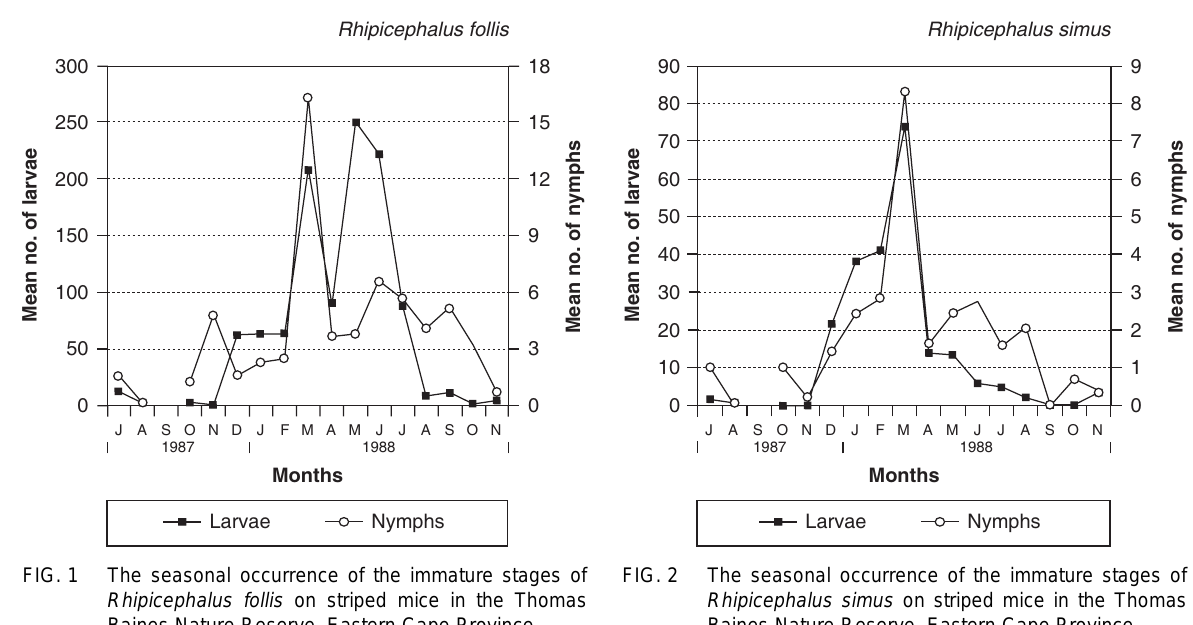
FIG. 1 The seasonal occurrence of the immature stages of FIG. 2 The seasonal occurrence of the immature stages of Rhipicephalus follis on striped mice in the Thomas Rhipicephalus simus on striped mice in the Thomas Baines Nature Reserve, Eastern Cape Province Baines Nature Reserve, Eastern Cape TABLE 2 Ixodid ticks collected from 14 Rhabdomys pumilio in the Grahamstown district Total number of ticks No. of rodents Tick species Larvae Nymphs Total infested Haemaphysalis leachi 42